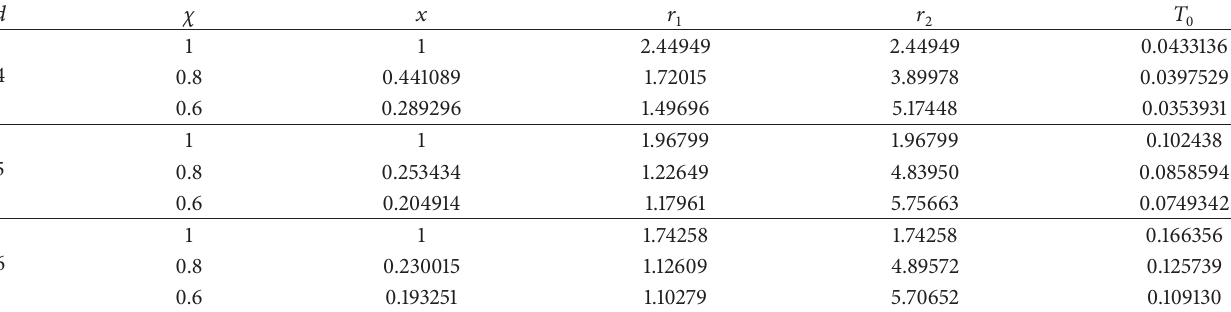
Table 2: Numerical solutions for 𝑥 , 𝑟 1 , 𝑟 2 , and 𝑇 0 at different pressures and different spacetime dimensions with 𝑞 = 1